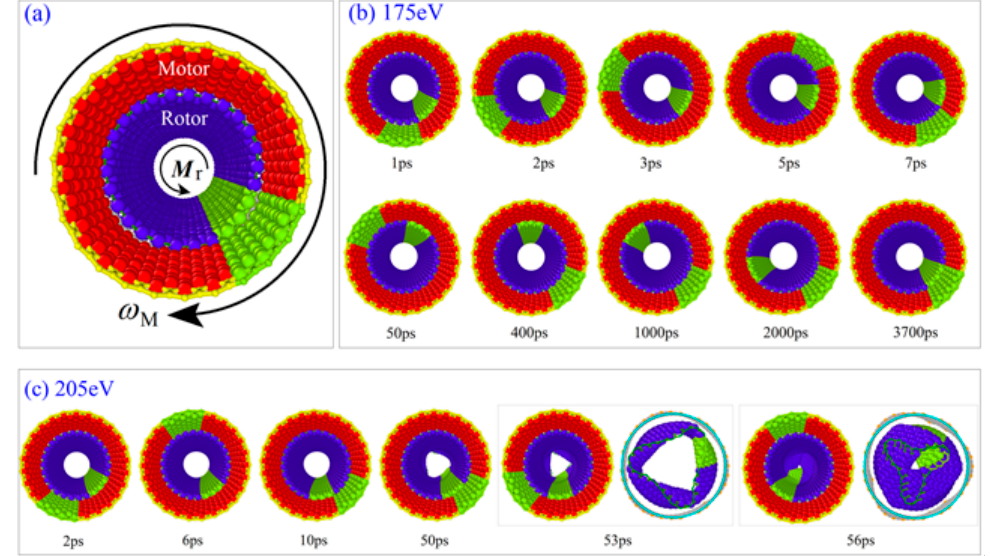
Figure 2. Relative rotation between motor and rotor in the zigzag model. ( a ) The perspective of the initial configuration after relaxation. ( b ) Snapshots of the system with M r = 175 eV, ω M = 150 GHz at 50 K. The rotor rotates a round after about 3700 ps. ( c ) Snapshots of the system with M r = 205 eV, ω M = 100 GHz at 8 K. The rotor has obvious buckling at 50 ps, the loading end of the rotor was enclosed after 56 ps.